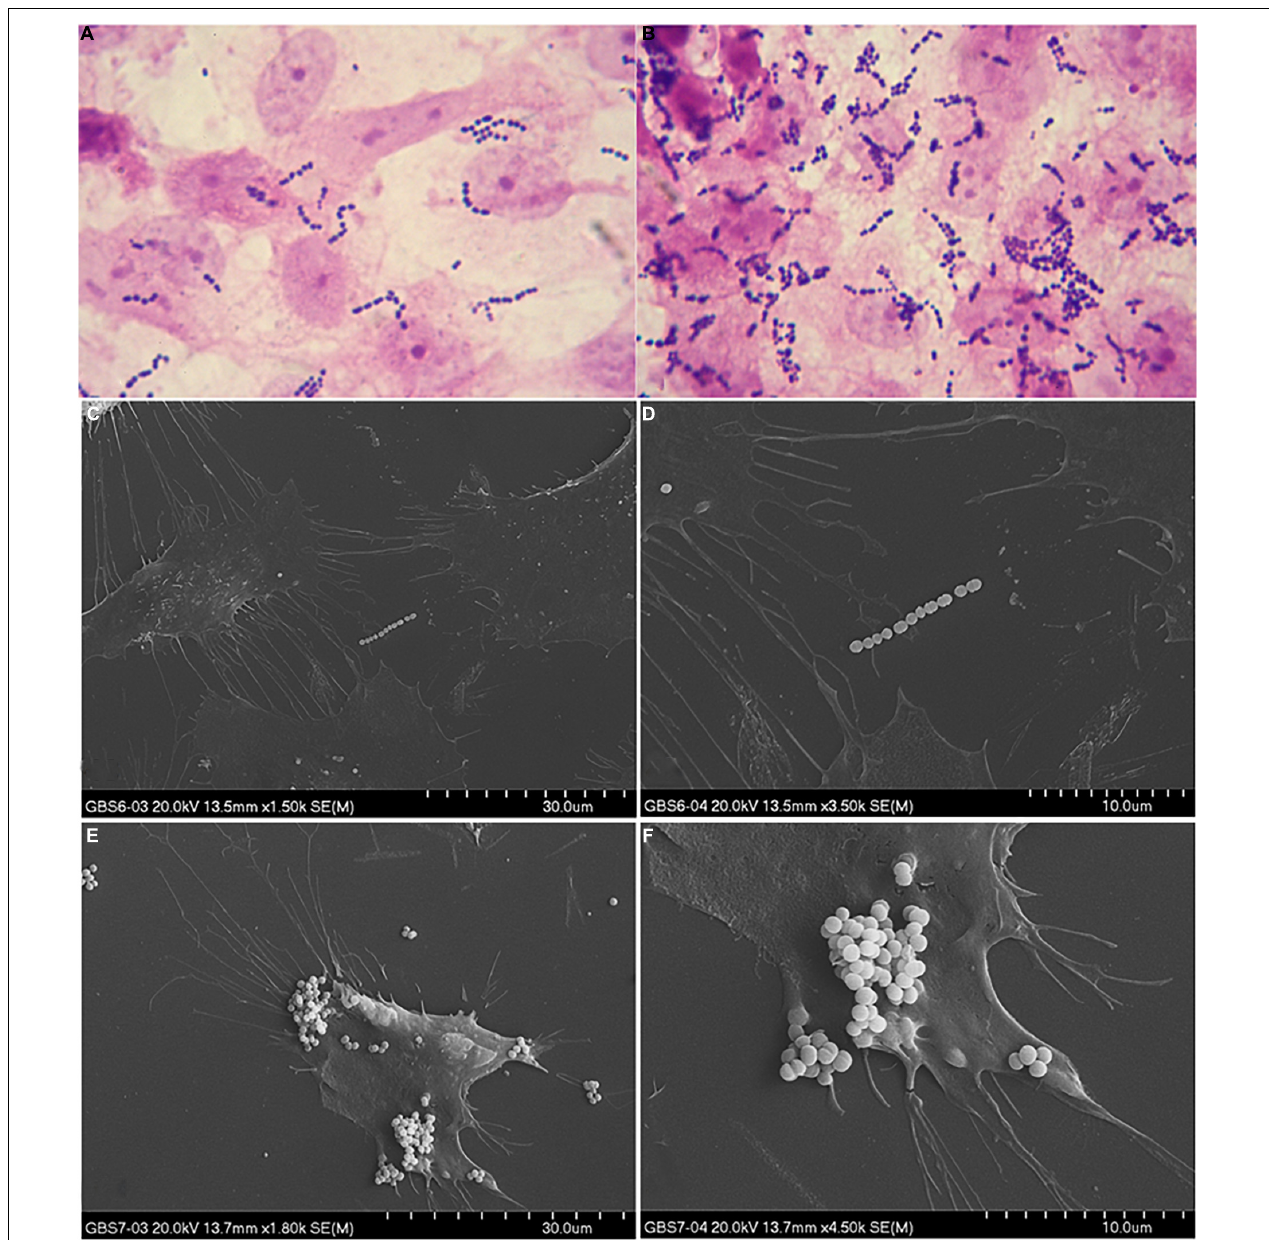
FIGURE 4 | Example of weak (A,C,D) and moderate (B,E,F) adherence ability to the HMVEC cell line. Adherence ability in (A,B) was observed in optical microscope (1000 × ), whereas in (C–F) adherence was observed in SEM in 1800 × (left side) and 4500 × (right side)